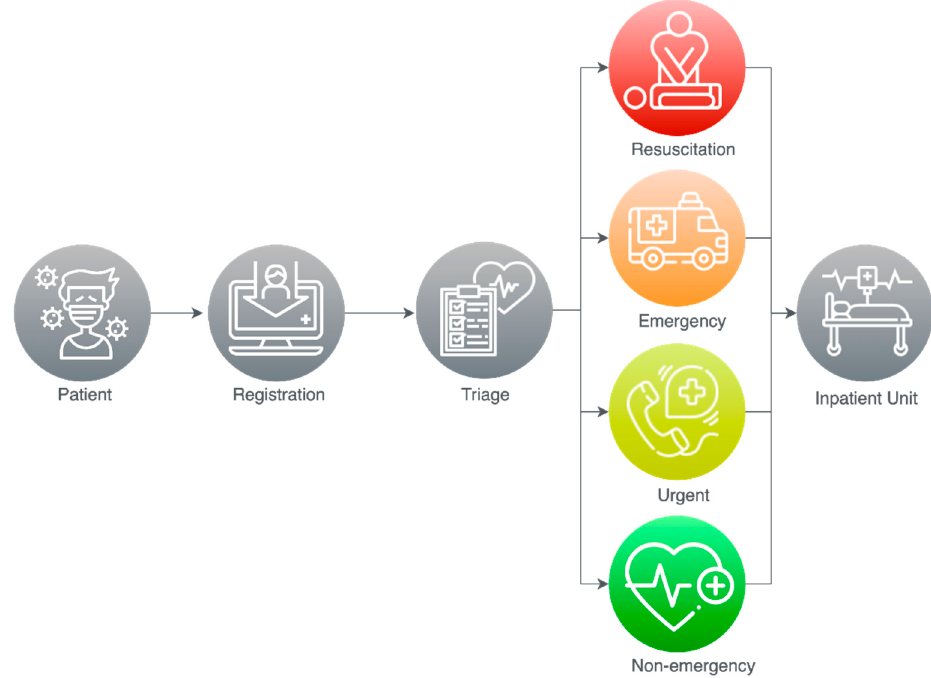
Figure 5. The procedure followed in the ED. Table 2. Comparison of general proposed ED triage